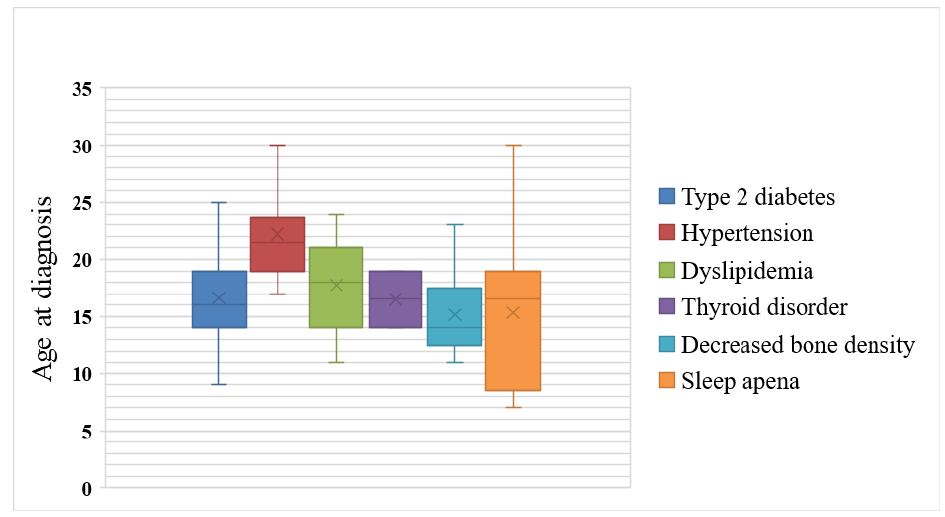
Figure 1. Box and whisker plot of age at diagnosis of endocrine and metabolic illnesses in young adults with Prader – Willi syndrome.